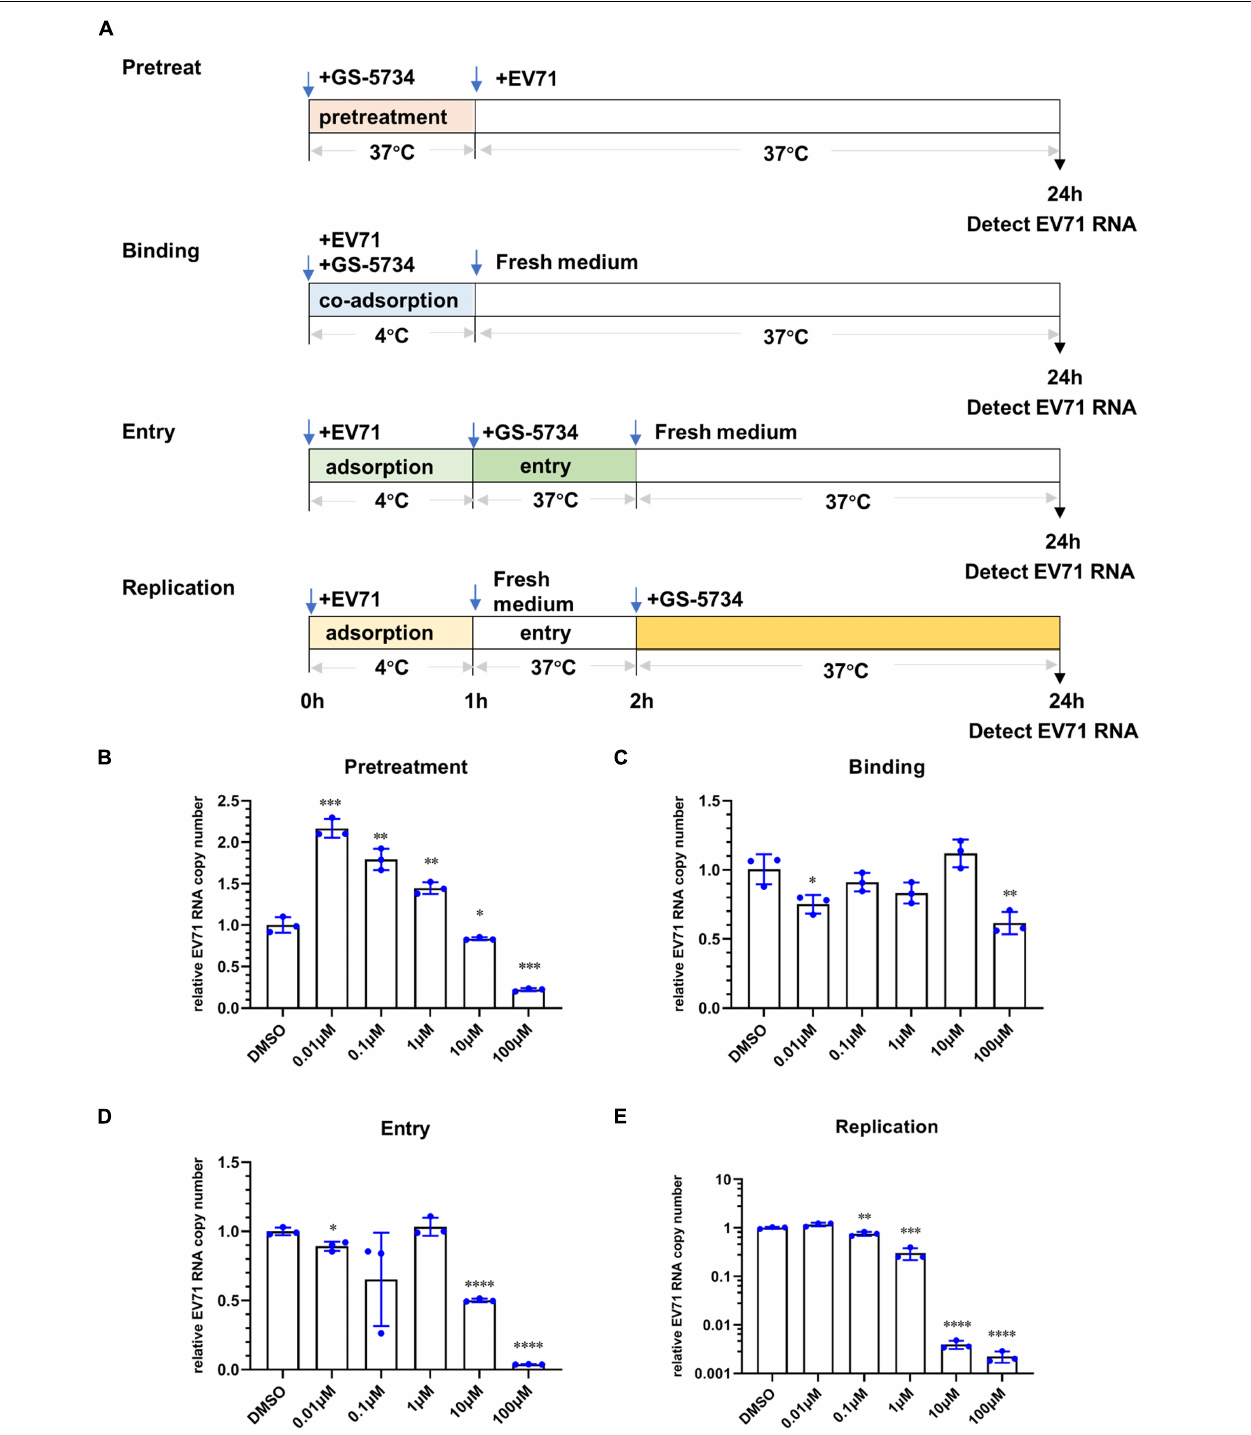
FIGURE 2 | Remdesivir inhibits EV71 replication post virus entry. (A) Schematic representation of the different treatment methods. Cells were pretreated with remdesivir (B) , coadsorbed remdesivir and EV71 (C) , remdesivir after EV71 adsorption that was removed after virus entry (D) , or remdesivir after virus entry (E) , and at 24 hpi, the EV71 viral RNA copy number was quantified by qRT-PCR (mean ± SD, n = 3). * P < 0.05, ** P < 0.01, *** P < 0.001, and **** P < 0.0001.